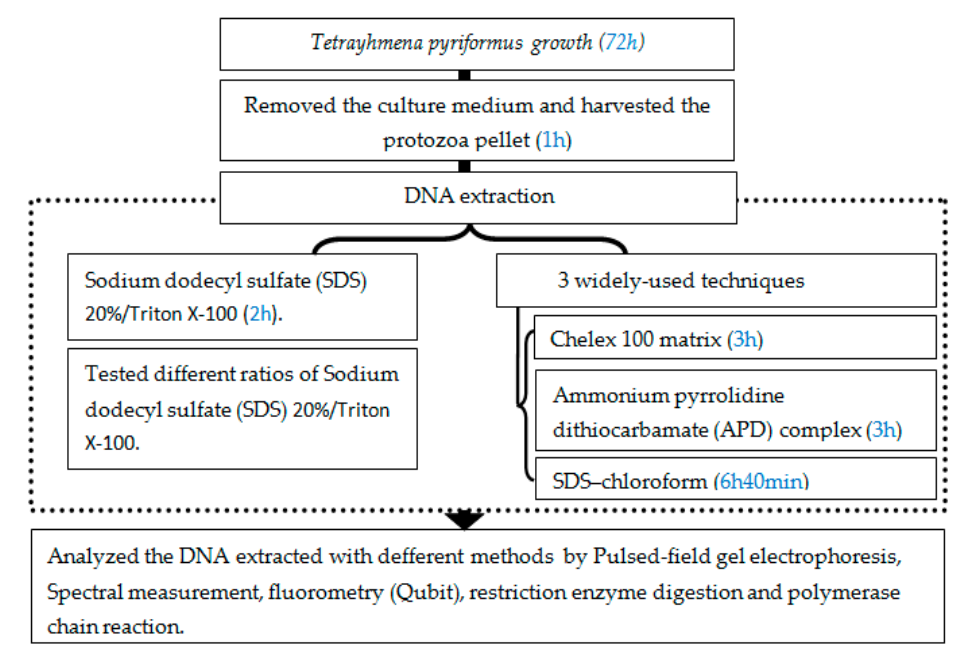
Figure 1. Experimental design for the extraction of DNA with sodium dodecyl sulfate (SDS)/Triton X-100, and the comparison of its quality and quantity with other widely-used methods.